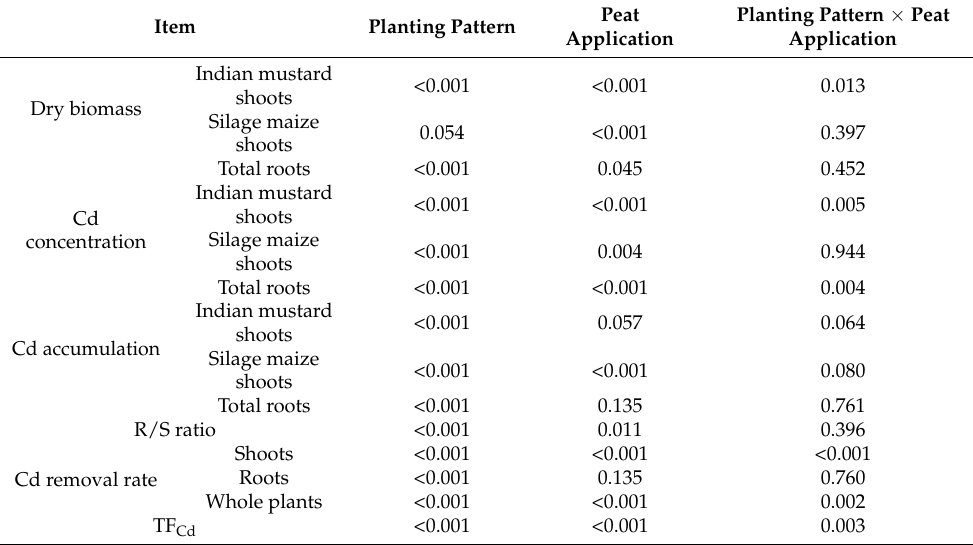
Table 4. ANOVA ( p values) of dry biomass, Cd concentration, and Cd accumulation in different parts (shoots and roots), and root/shoot (R/S) ratio, Cd removal rate, and Cd translocation factor (TF Cd ) of Indian mustard and/or silage maize plants in different treatments. Peat Planting Pattern × Peat Item Planting Pattern Application Application Indian mustard <0.001 shoots Dry biomass